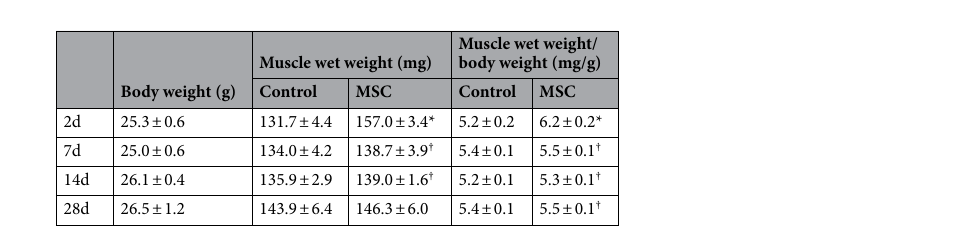
Muscle protein breakdown related factors. The expression of ubiquitinated proteins increased after the injection of MSCs (the main effect of MSCs, Fig. 5A,H indicates representative blot data). The expression of K48 linkage-specific polyubiquitin also increased after the injection of MSCs (main effect of MSCs, Fig. 5B). The mRNA expression of MuRF-1, a muscle-specific E3 ubiquitin ligase, increased at 2 days after the injection of MSCs (Fig. 5C). Similarly, the mRNA expression of atrogin-1, another muscle-specific E3 ubiquitin ligase, increased 2 days after the injection (Fig. 5C). Another muscle-specific E3 ubiquitin ligase MUSA1 increased